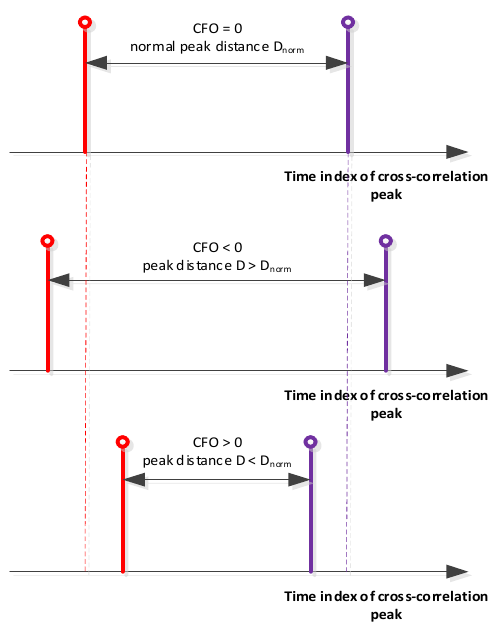
Figure 10. Algorithmic idea of ICARUS joint timing and Doppler sync.